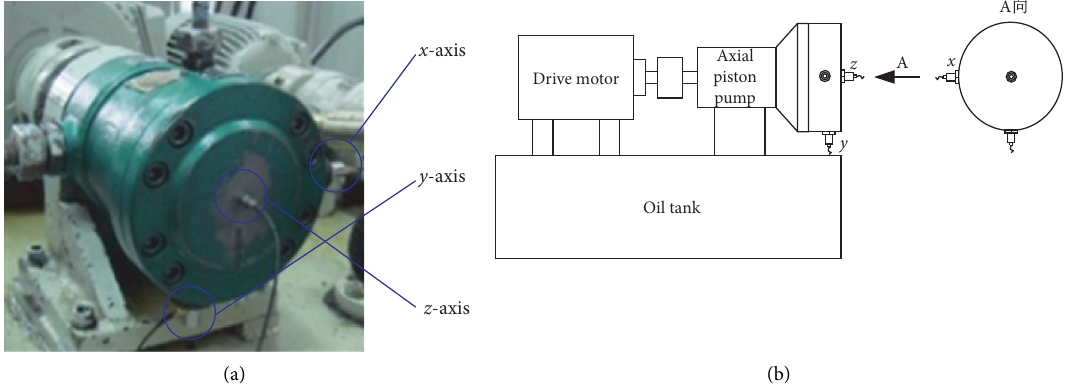
Figure 7: Installation of acceleration sensors. (a) Physical map. (b) Sketch map.